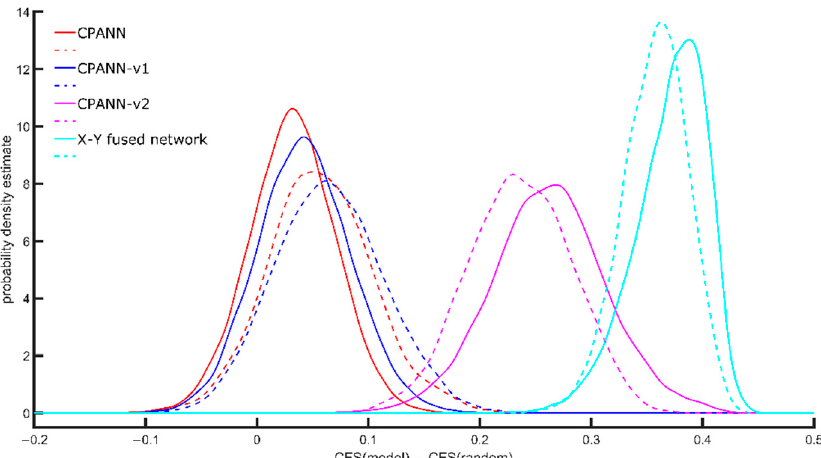
Figure 1. Probability density estimate of differences CFS(model)–CFS(random) obtained for models developed using different training algorithms. Solid lines represent the distribution for selected models obtained from optimizations with 268 descriptors in the training set, dashed lines represent distributions for selected models obtained from optimizations with 49 descriptors in the training set.